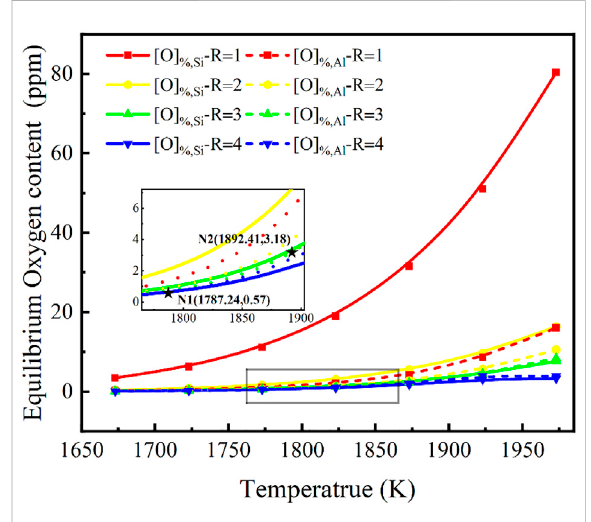
FIGURE 4 Relationship between basicity in CaF 2 -CaO-Al 2 O 3 -MgO-